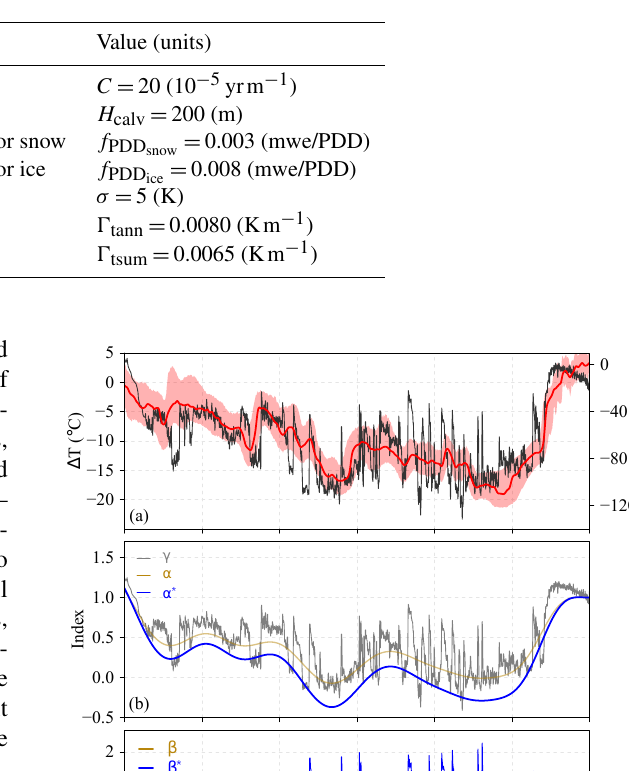
Table 1. Key ice-sheet model and climate forcing parameters. Conversion factor units are meters of water equivalent per positive degree day (mwe/PDD).